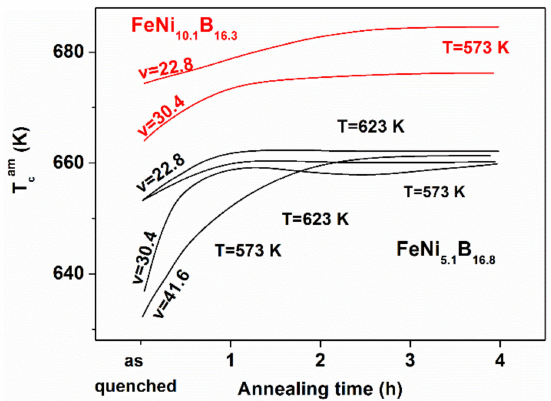
Figure 15. Evolution of the Curie temperature T Cam for various (FeNi) 83 B 17 samples in as-quenched state and during the di ff erent isothermal heat